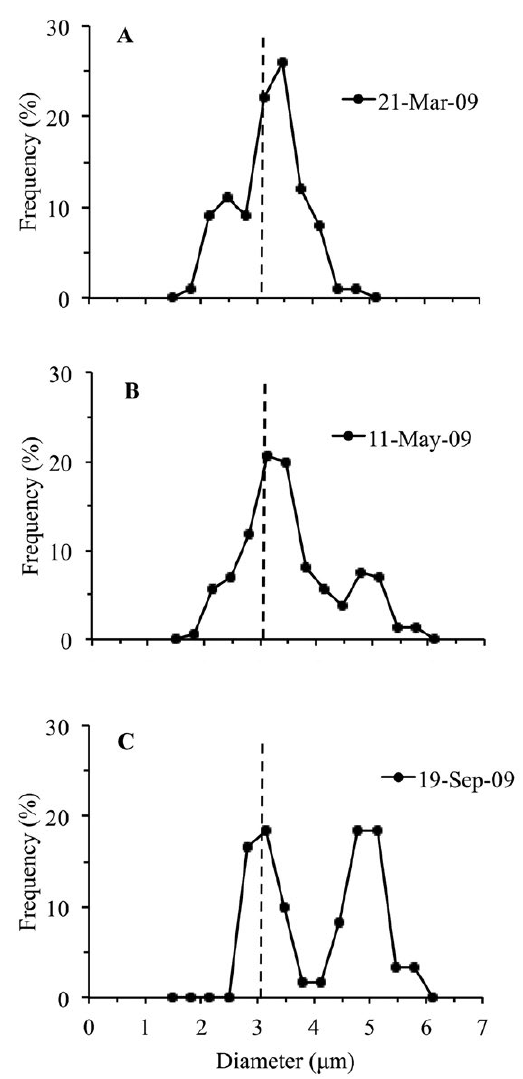
Fig. 5. – Cell diameter size distribution of Minidiscus comicus, expressed as relative occurrence, in a) 21/22March (n=100), b) 11 May (n=160) 2009 and c) 19 September 2009 (n=60). The size class used was 0.33 μm . The vertical dashed line indicates the threshold below which size restoration can be induced.